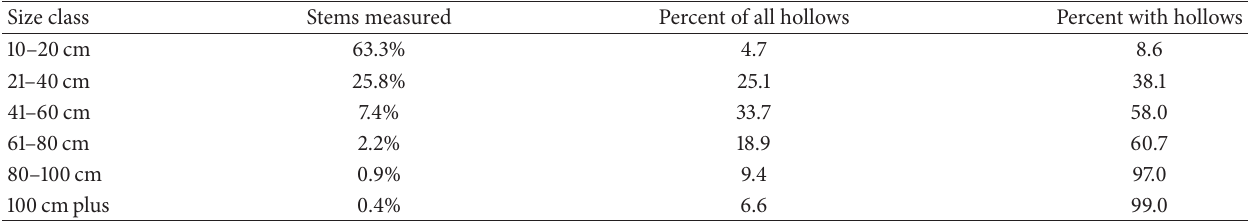
Table 1: Distribution of stem sizes and the number of hollows within diameter size classes.